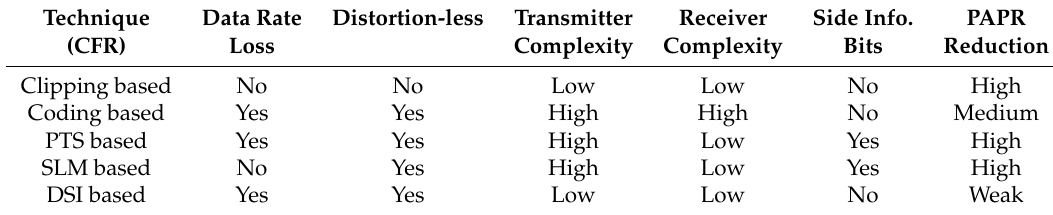
Table 1. Review of common peak to average power ratio (PAPR) reduction